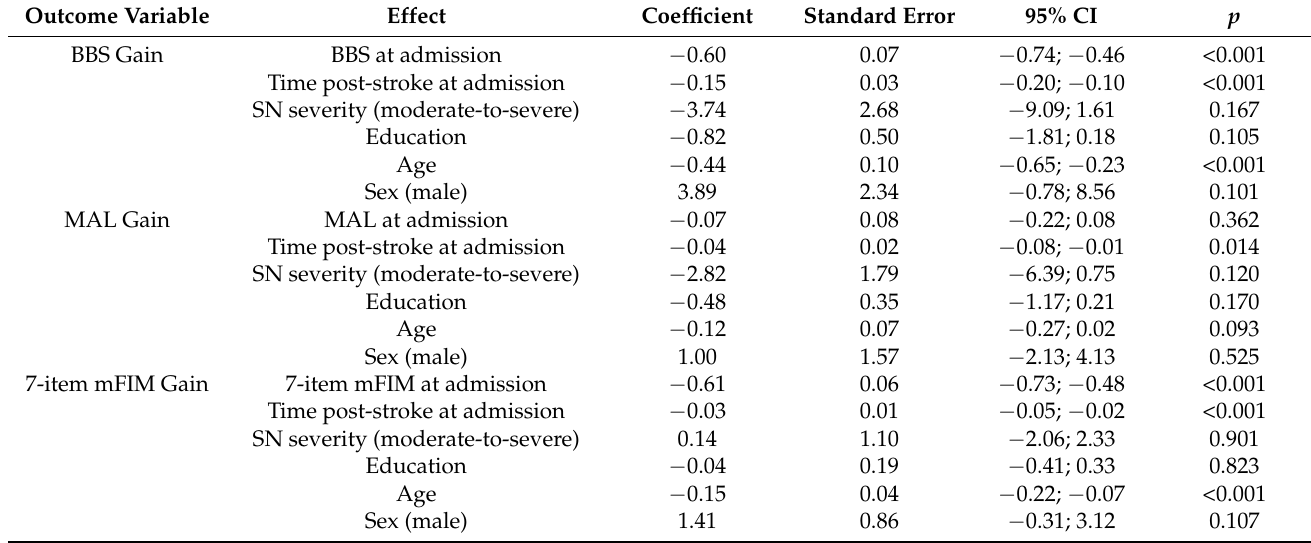
Table 6. Parameter estimates of the GLM (patients with mild SN vs. patients with moderate-to-severe SN). Outcome Variable